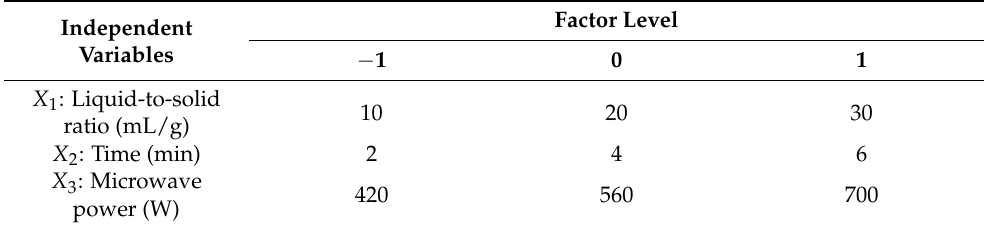
Table 1. Independent variables and their levels in the response surface